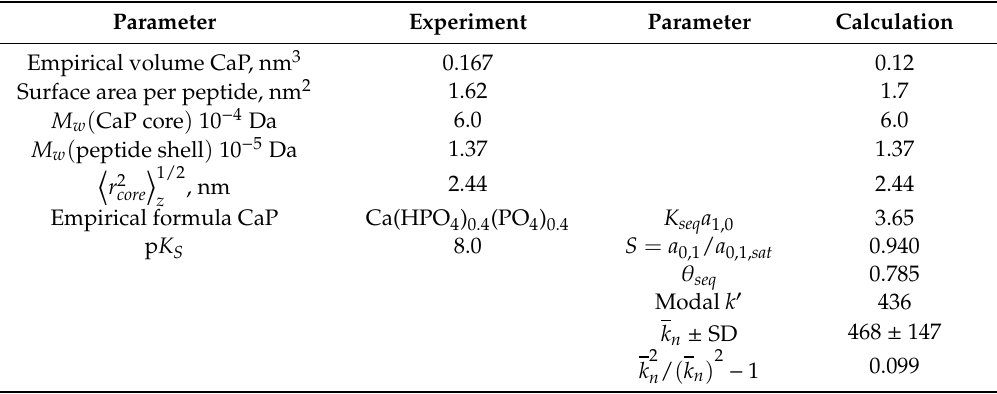
Table 2. Comparison of experimental average values of the core and shell weight average molar masses and the core root mean square radius [111] with calculated values from a theoretical distribution calculated from Equation